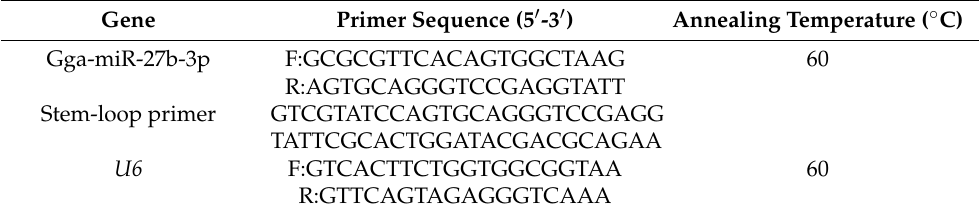
Table 1. miRNA primers used for